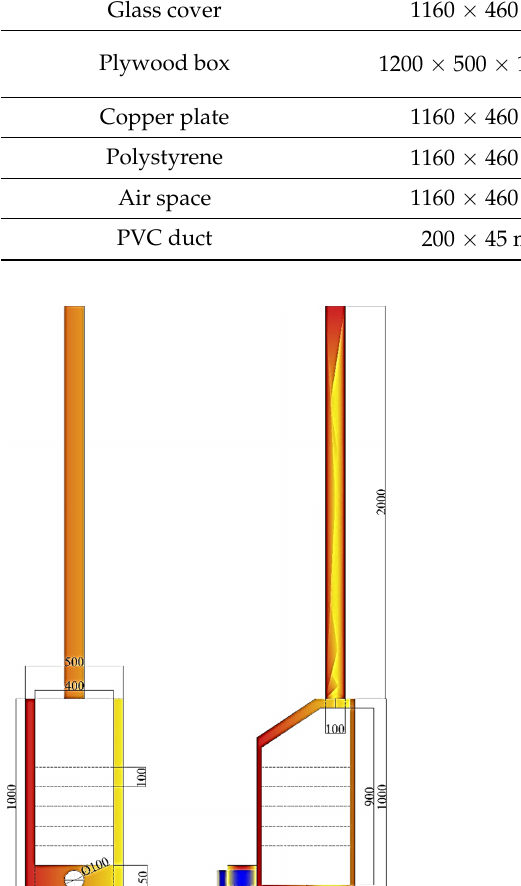
Figure 1. Technical drawing of a solar dryer with circular chimney. Energies 2022 , 15 , x FOR PEER REVIEW